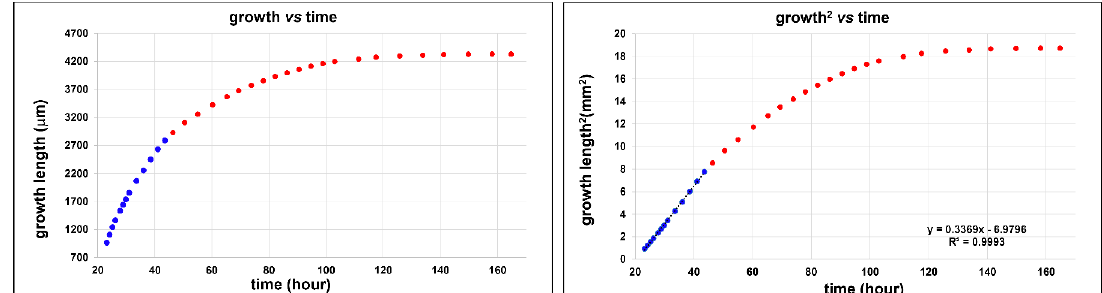
Figure 9. Measured values of the crystal size ( left ) and its square ( right ) plotted versus time for the middle and final stage of the growth process (23–164 hours, gel density 1 w / v %). The shape of the curve changes over time (blue and red dots) suggesting a change in the growth mechanism. Only some selected experimental data points have been reported for clarity. Dotted lines show the fitting of the data according to the relation reported alongside the curve. The linear size of the crystals in di ff erent growth directions parallel to the focusing plane of the camera has been measured. The absolute values are direction-dependent but the growth behaviour is the same for any directions.